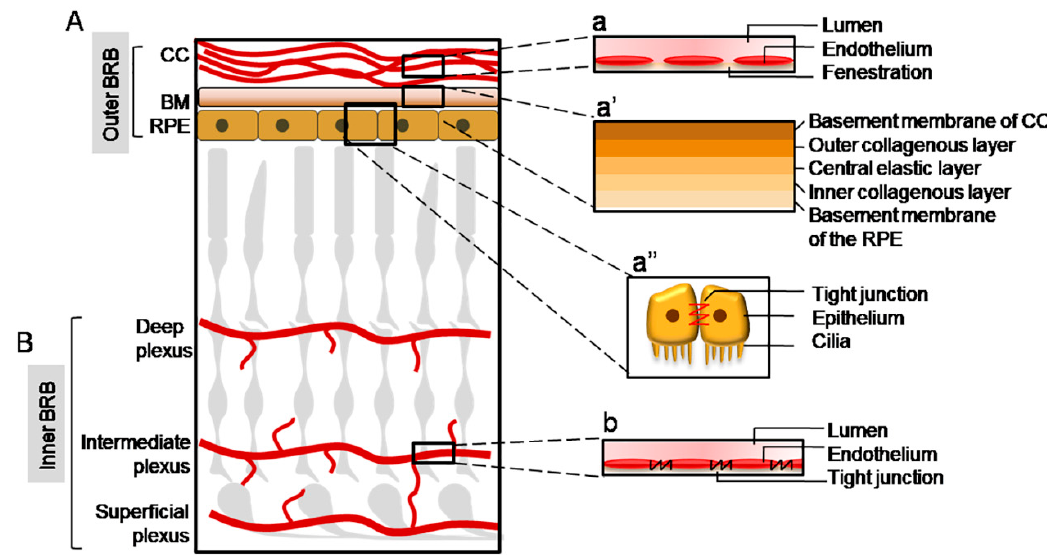
Figure 1. Schematic illustration of the blood ‐ retinal barrier (BRB) structure. ( A ) The outer BRB insulates the outer retina from the bloodstream deriving from the choriocapillaris (CC), whose endothelium shows multiple fenestrations (a). The molecules reach the neuroretina through the Bruch’s Membrane (BM), composed of five layers, which forms a size ‐ selective barrier (a’), and through the retinal pigment epithelium (RPE), characterized by tight junctions (a’’). ( B ) The inner BRB insulates the inner retina from the retinal vasculature, composed by a deep, intermediate, and superficial plexus; the endothelial cells of the retinal vessels form an effective barrier because of the presence of tight junctions among them (b).